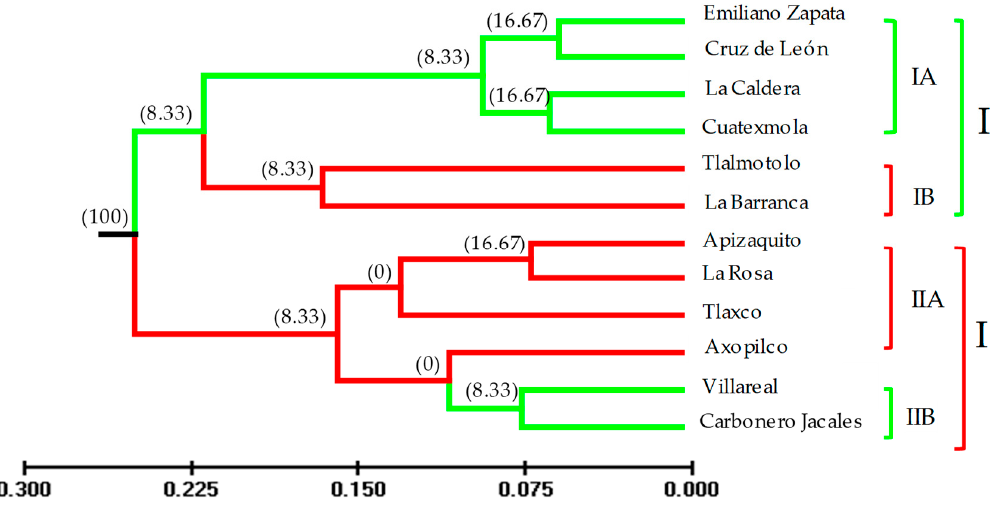
Figure 3. UPGMA dendrogram of 12 natural populations of Pseudotsuga menziesii (Mirb.) Franco, constructed from genetic distances [39]. Support values for each branch are indicated in parentheses.